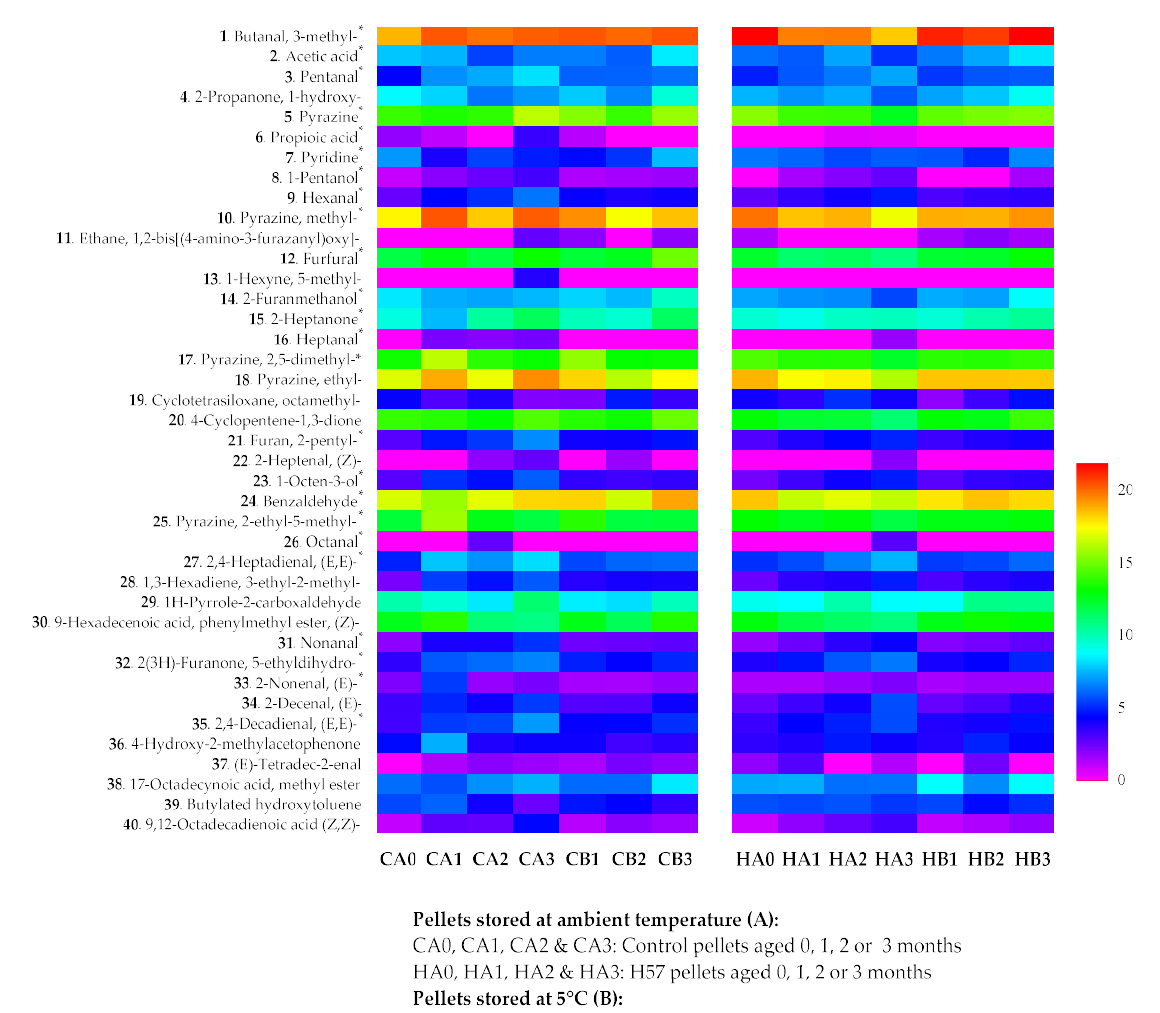
Figure 6. Heatmaps of volatile organic compounds (AU x 10 5 , µ m 2 ), listed in order of retention time, in the pellet treatments measured by a qualitative analysis of GC/MS. * Microbial volatile organic compounds were identified by details given at http://bioinformatics.charite.de/mvoc/index.php?site=home (accessed on 10 September 2019).